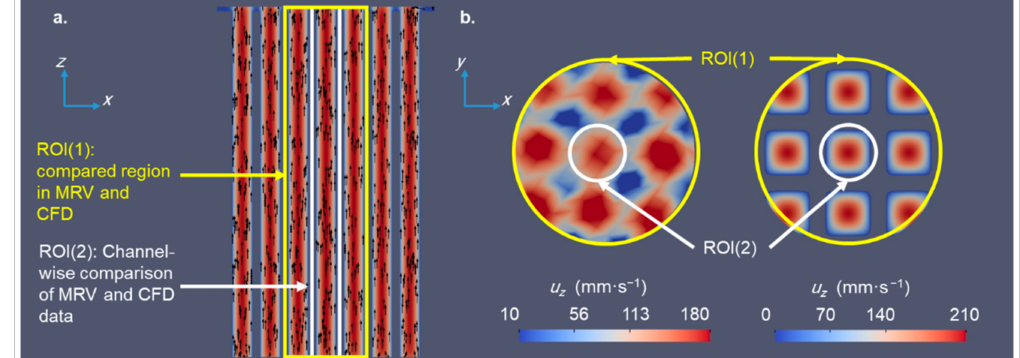
Figure 8. ( a ) The chosen regions of interest (ROIs) selected to compare MRV and CFD data. ( b ) z -component of velocity in a central slice (ROI(1)) in experimental and numerical data. The depicted ROI for MRV data is tilted away from the CFD data by some degrees. As the comparison of velocity in ROIs was conducted based on the averaged velocity profile over the cross-sections, the rotated channels do not affect the comparison.